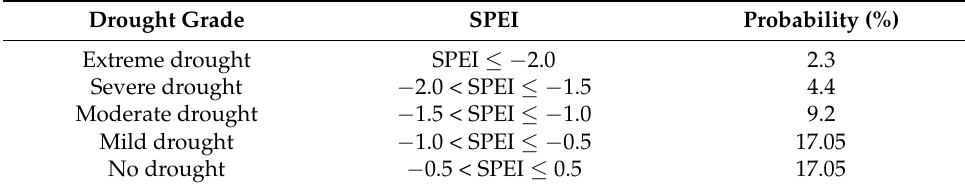
Table 1. Drought grade classification based on the SPEI and corresponding event probabilities. Drought Grade SPEI Probability (%) SPEI ≤ − Extreme drought Severe drought Moderate drought Mild drought No drought